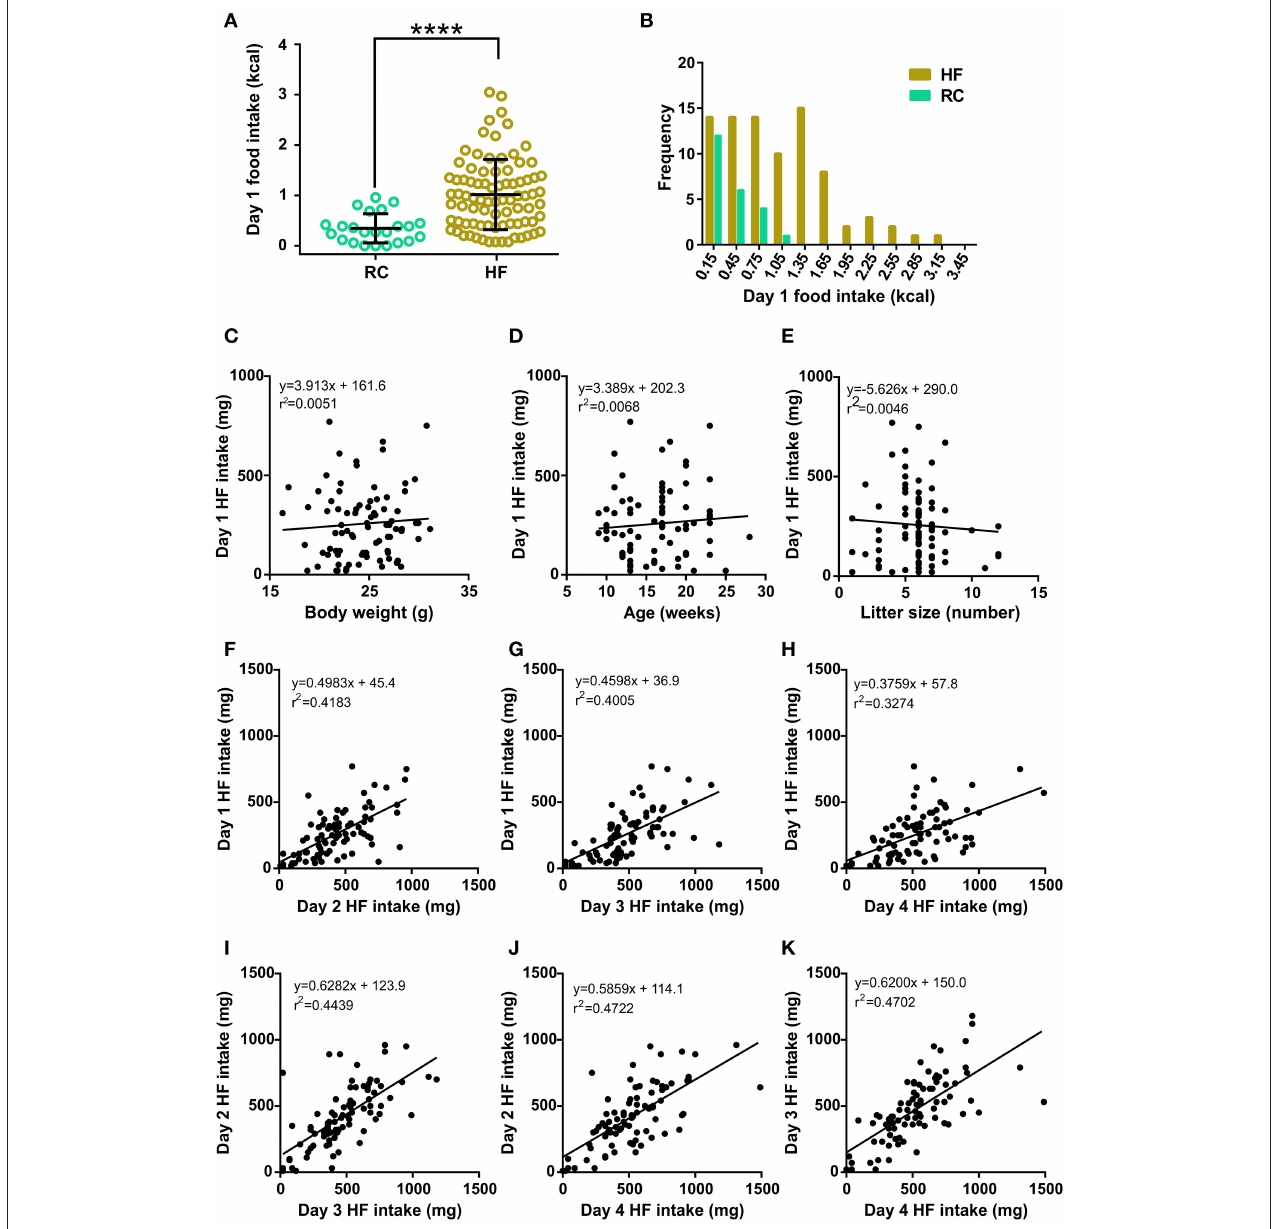
FIGURE 1 | (A) Dot plot of the individual food intake values of RC (light green circles, n = 23) and HF (khaki circles, n = 84) groups. Lines represent the mean and SD of each group. **** p < 0.0001, Mann-Whitney test ( U = 346.5). (B) Corresponding histograms of food intake for HF and RC mice. (C–E) Scatter plots of day 1 HF intake vs. body weight (C) , age (D) , and litter size (E) . In each case, the linear regression between both parameters is shown, along with the corresponding equation and R squared. (F–K) Scatter plots of day 1 HF intake vs. day 2 HF intake (F) , day 3 HF intake (G) , and day 4 HF intake (H) ; day 2 HF intake vs. day 3 HF intake (I) and day 4 HF intake (J), and day 3 HF intake vs. day 4 HF intake (K) . In each case, the linear regression between both parameters is shown with the corresponding equation and R squared. All linear regressions presented a slope significantly different from zero according to an F test [in (F) : p < 0.0001, F = 58.96; in (G) : p < 0.0001, F = 54.78; in (H) : p < 0.0001, F = 39.91; in (I) : p < 0.0001, F = 65.43; in (J) : p < 0.0001, F = 73.37 and in (K) : p < 0.0001, F =